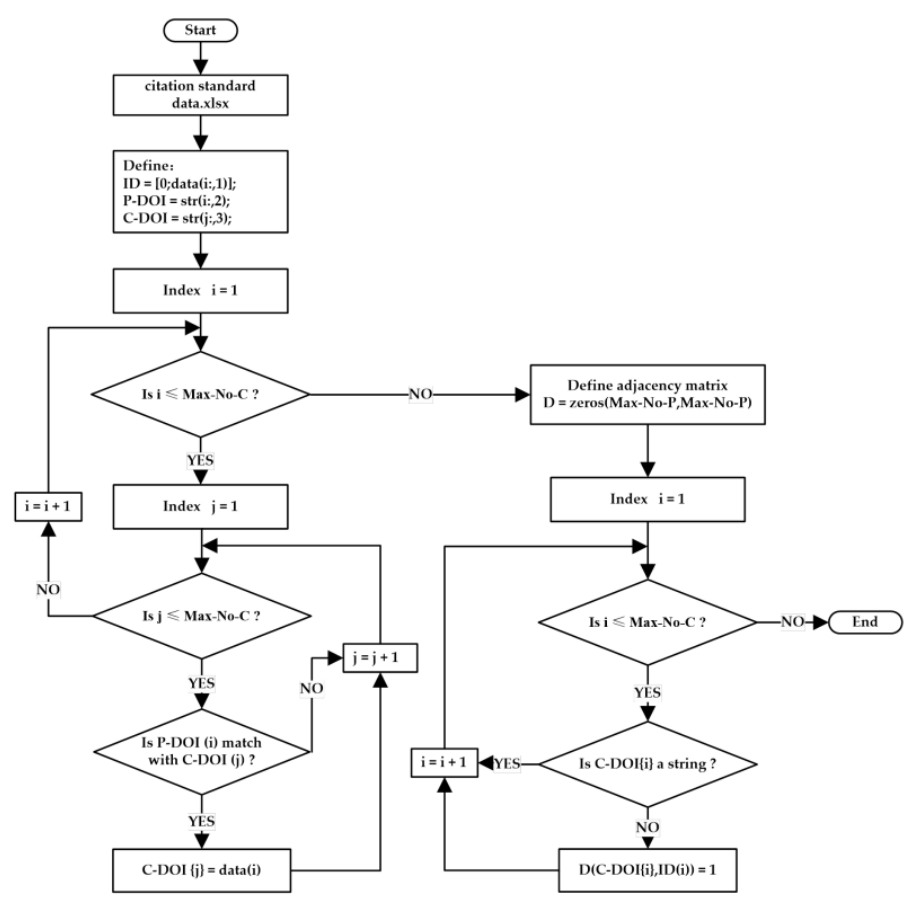
Figure 1. Flow chart of citation matrix construction.